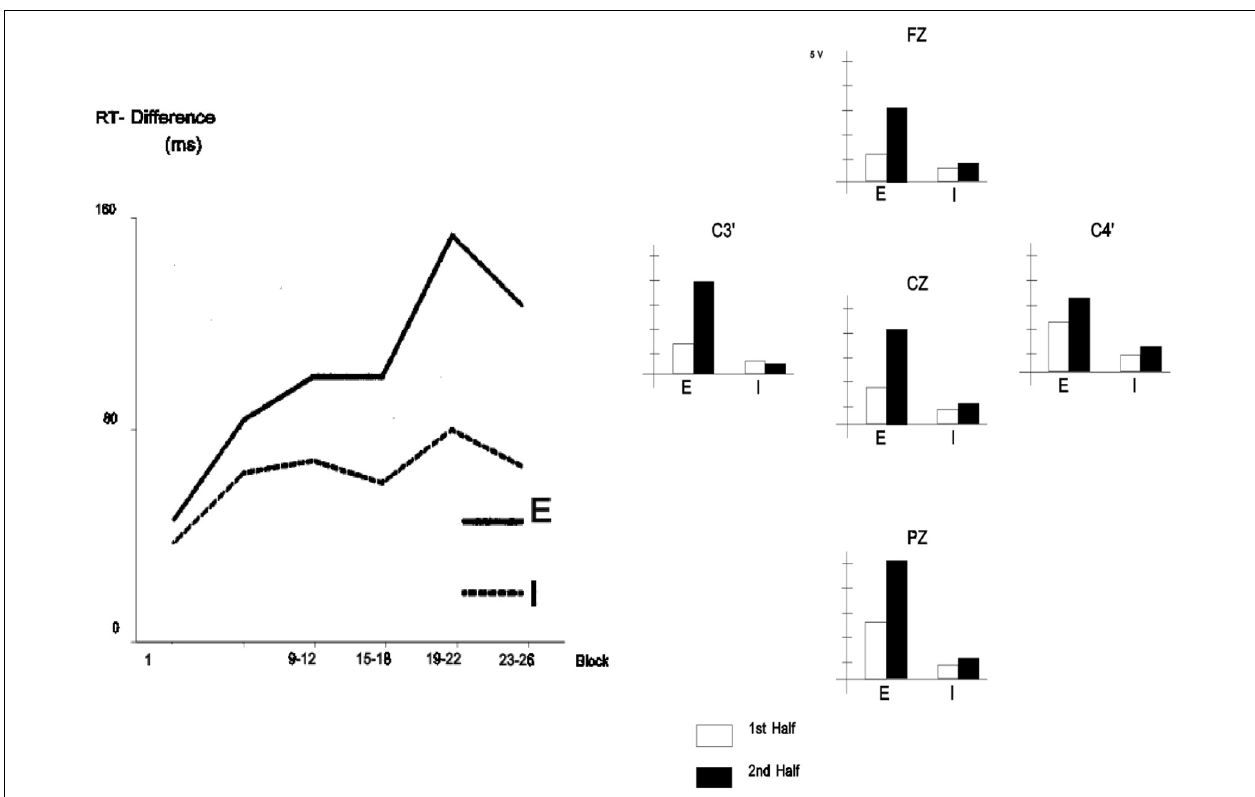
presence of a sequence when asked after the experiment). Right panel: Mean ERP amplitude in the 240–340 ms poststimulus onset time range (corresponding to the N2 component) to the deviant stimulus (ungrammatical sequences) minus ERP to the standard stimulus (grammatical sequences) under implicit (“I”) and explicit conditions (“E”) from the first and second halves of the blocks. (Reproduced with permission from Eimer etal.,